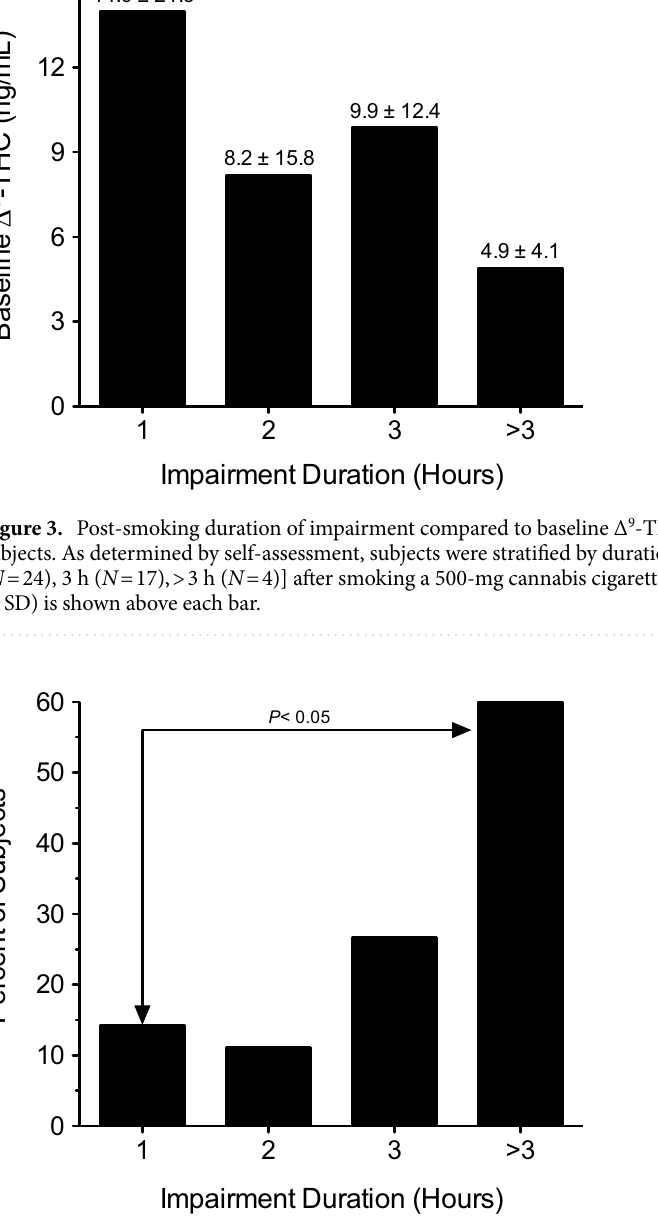
Figure 4. Relationship between duration of impairment and the incidence of nystagmus. A total of 44 subjects were assessed for nystagmus prior to smoking and at various time points up to three hours post-smoking (43/44 subjects were evaluated at three hours post-smoking). As determined by self-assessments, subjects were stratified by duration of impairment, 1 h ( N = 14), 2 h ( N = 9), 3 h ( N = 15), or > 3 h ( N = 5), and the incidence of nystagmus at three hours post-smoking was